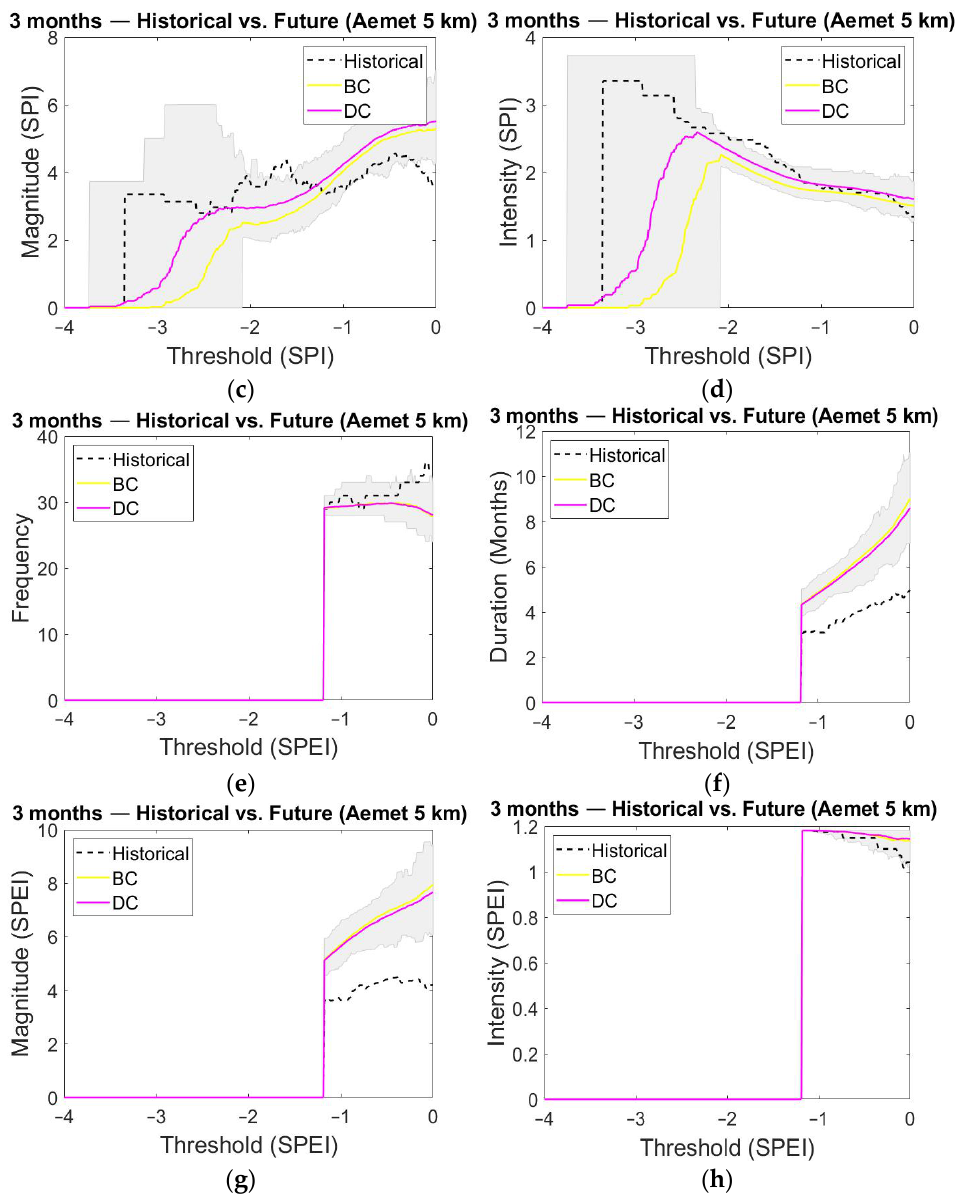
Figure 8. Historical and future meteorological drought ( a ) frequency; ( b ) mean duration; ( c ) mean magnitude; ( d ) mean intensity derived from SPI for the 3 months temporal-aggregation scale (Spain02 database). Historical and future meteorological drought ( e ) frequency; ( f ) mean duration; ( g ) mean magnitude; ( h ) mean intensity derived from SPEI for the 3 months temporal-aggregation scale (Aemet 5 km database).